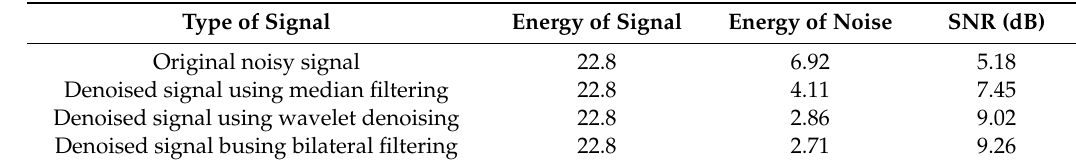
Table 2. SNR of synthetic structural damped free vibration